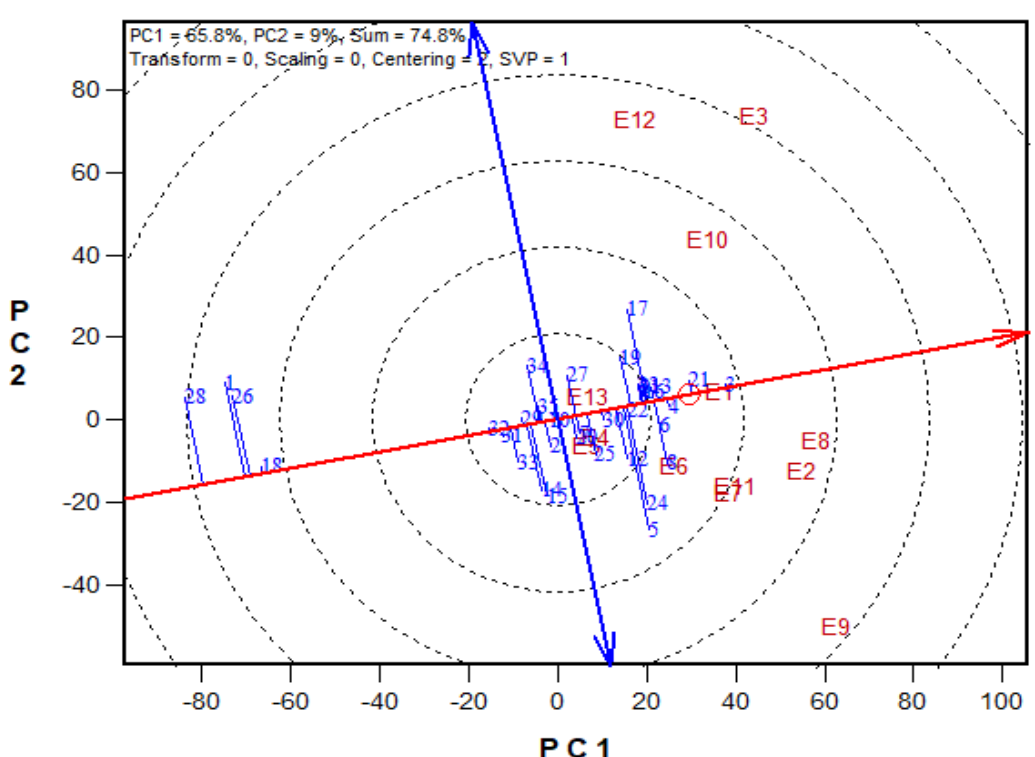
Figure 3. A Mean vs. Stability view based on a genotype × environment yield data of 29 early maturing pro-vitamin A hybrids and 6 checks evaluated in 13 environments under drought, low-N, Striga infestation and optimal conditions between 2016 and 2017. The biplot was based on environment-focused singular value partitioning (‘SVP = 1) and is therefore appropriate for visualizing the relationships among genotypes. Principal component (PC)1 and PC 2 explained 51.1% of yield variation.